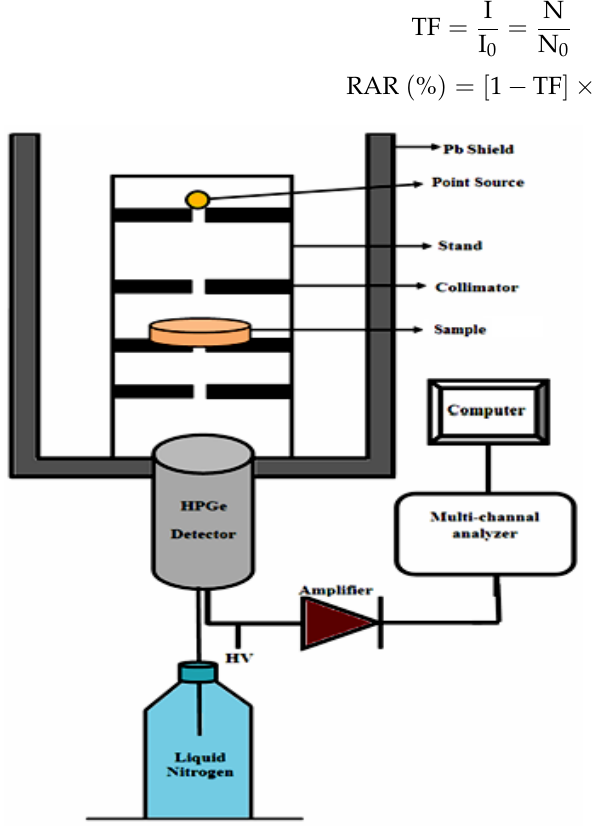
Figure 3. The arrangement of the experimental work.